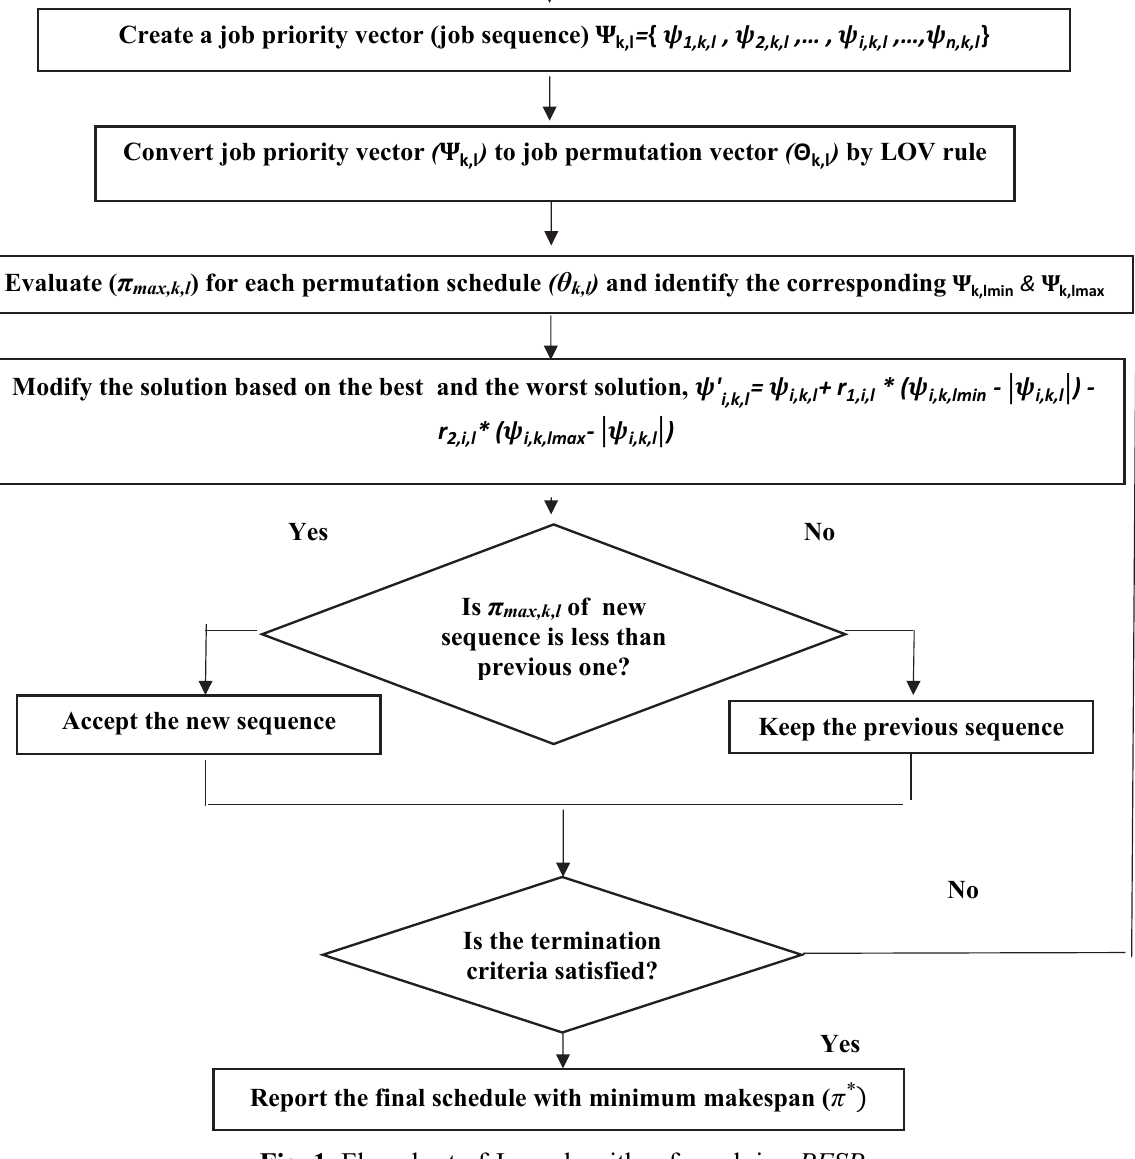
Fig. 1. Flowchart of Jaya algorithm for solving PFSP Processing times of jobs Jobs/